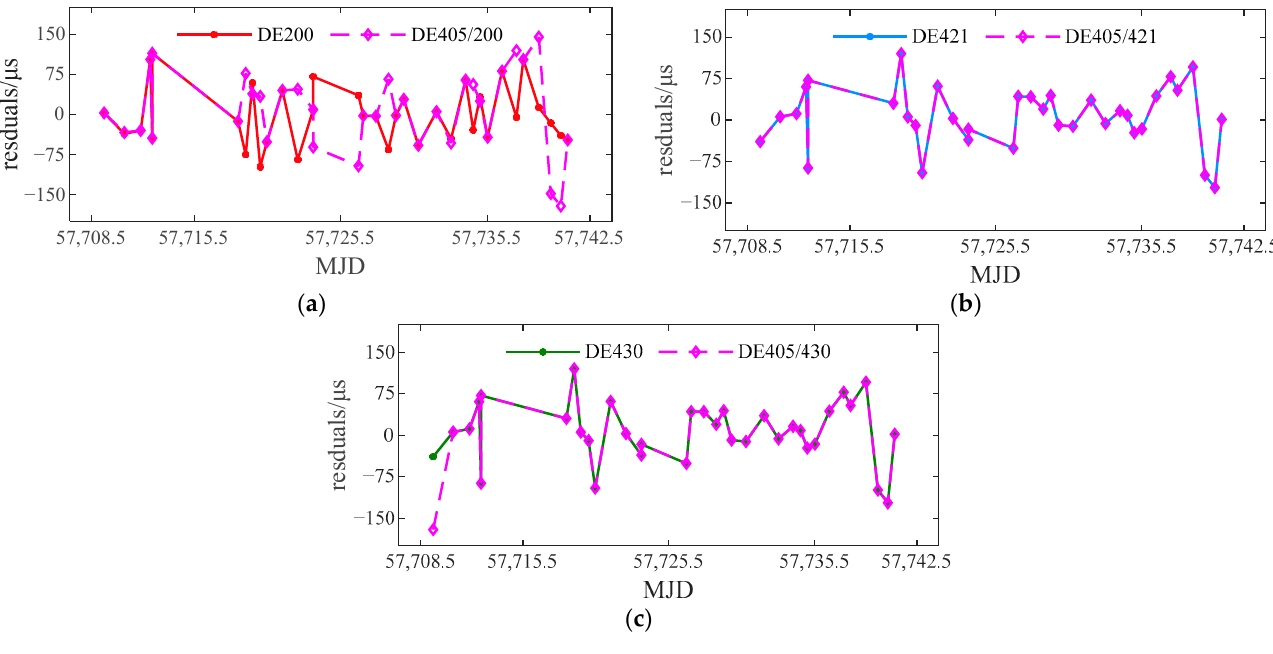
timing residuals of the original DE200, the purple curve represents the timing residual mixed with